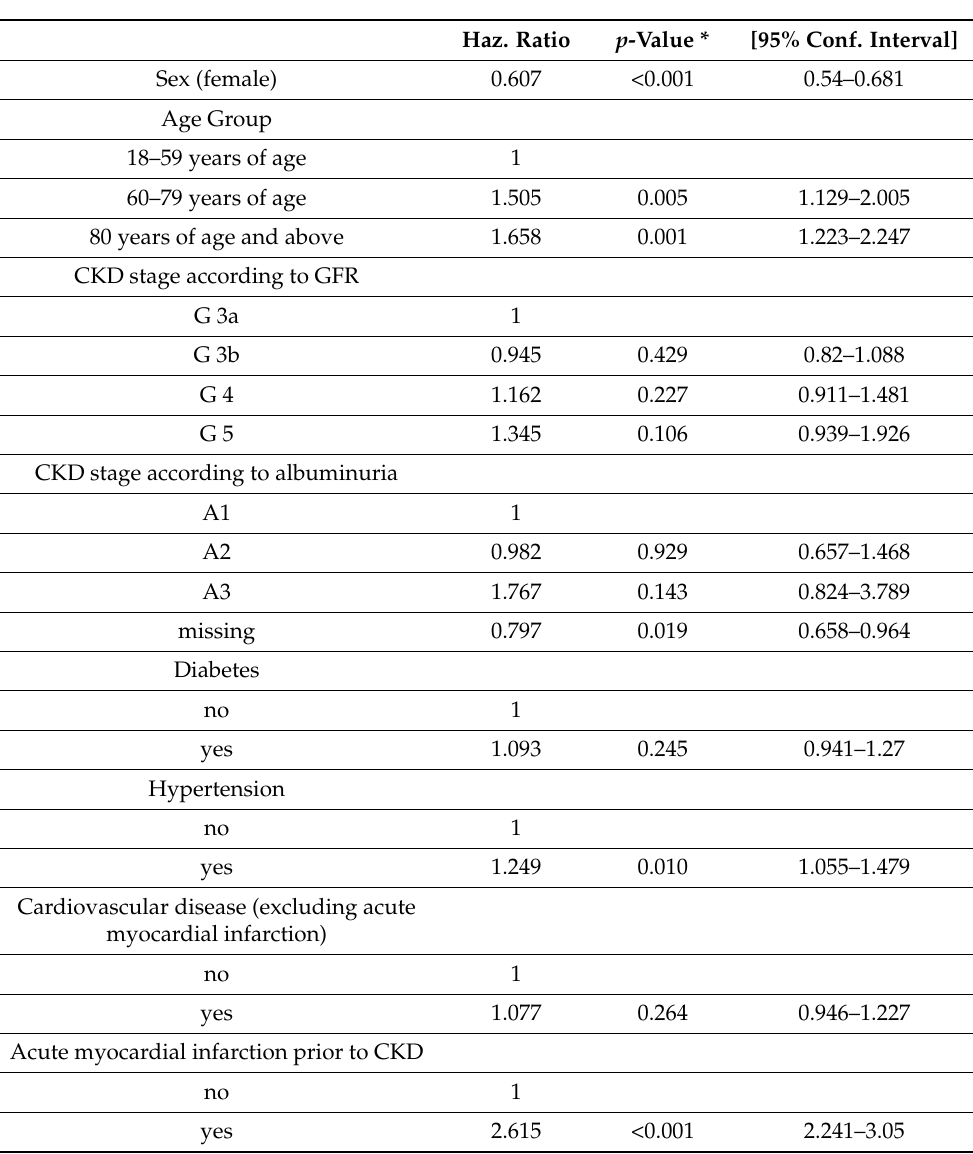
Table 3. Hazard ratio of AMI during 5-year follow-up in CKD G3–5 patients with and without prior